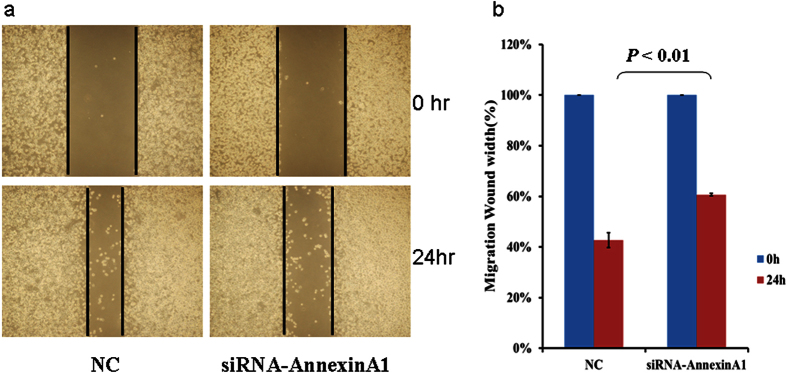
Knockdown of Annexin A1 by siRNA inhibits AGS cell migration.AGS cells were transfected with either control (NC) or Annexin A1 siRNA for 6 hours and migration was assessed by wound healing assay using 6-well plates. (a) Representative images of wound healing assay. (b) Bar graph showing migration as percentage of AGS cell migration at 0 hour.